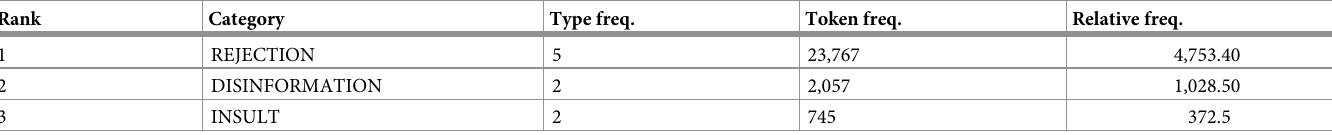
statistically significant ( p < 0.001), showing lower than expected token frequency in relation to type frequency for anti-mask hashtags and the opposite trends for pro-mask hashtags. Themat- ically, the semantic opposition between pro- and anti-mask hashtags is especially clear in the antonymic pairs, e.g. #MaskOn vs. #MaskOff, #MasksSaveLives vs. #MasksKill, #MasksWork vs. #MasksDontWork, and #MaskMandate vs. #NoMaskMandates. Table 3 shows the type, token, and relative frequencies of the four subcategories of the pro- mask hashtags. The majority of pro-mask hashtags fall in the subcategory HORT in which six types contain expletive attributives (e.g. damn, fucking, freaking ). These expletive attributives are known as emotive intensifiers and serve the purposes of intensifying the affective strength of language and demanding attention to what is being said [53]. They help create an emotion- ally charged atmosphere in the urgent calls to action. The HORT subcategory was broken down into expletive hortatives and non-expletive or neutral hortatives. A Fisher’s Exact Test showed a non-significant lower than expected token frequency relative to type frequency for expletive_HORT and the opposite for neutral_HORT ( p = 0.277). Table 4 shows the type, token, and relative frequencies of the three subcategories of anti-mask hashtags with REJEC- TION on the top, followed by DISINFORMATION. Concerning the trends of the pro-mask hashtags (Fig 1), the first crest occurred in early April with a sharp spike of #Mask(s)(4)All, coinciding with the CDC recommendation of face masks. The second crest occurred in late May with #WearAMask leading the way. This drops to a deep trough in early June, followed by the third and most dramatic crest involving simul- taneous surges of multiple hashtags around mid June that peaked in late June and early July with the top three being #WearAMask, #WearADamnMask and #MaskUp. These went down and up again in mid July to a fourth crest, which dipped abruptly at the end of July. The mask- related news headlines form clusters that roughly coincide with the growth peaks of the hash- tags, dropping into a hiatus in June with only two headlines on CDC reminders of mask guide- lines before the next cluster around early July. As can be seen in the color coding of the headlines, White House violations of the CDC guidelines were intensely reported in the earlier months, interspersed with headlines on mix-messaging by the White House. There was a scat- tering of both types of content even in July when finally Trump donned a mask. Unlike the pro-mask hashtags, the anti-mask hashtags showed no marked peak in early April but exhibited similar temporal trajectories to those of the pro-mask hashtags for the remaining time period (Fig 2). We see a similar upswing starting May, which reached the first Table 4. Functional subcategories of anti-mask hashtags ranked by relative frequency. Rank Category Type freq. Token freq. Relative